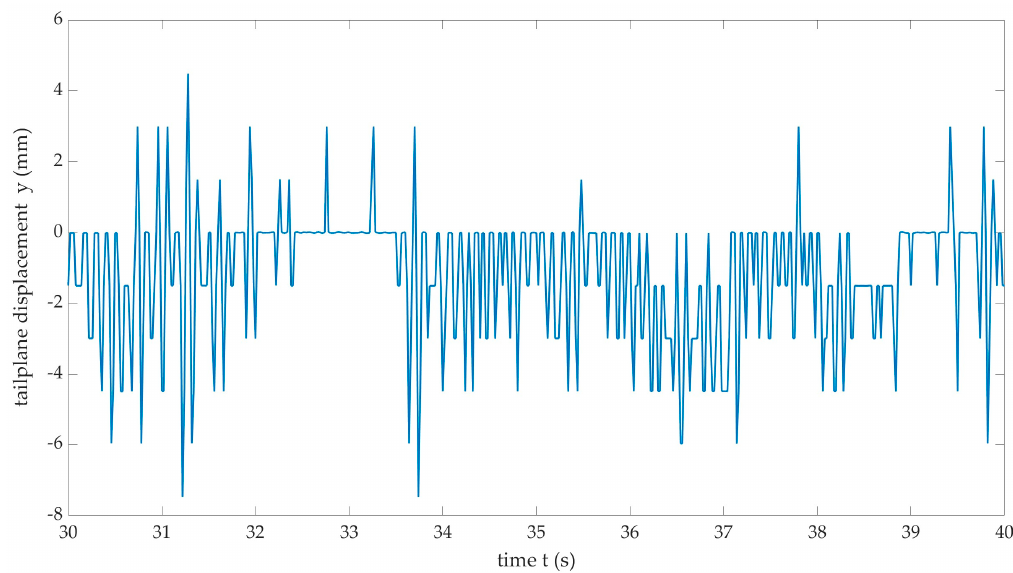
Figure 10. Sample window of time series displacement data from GoPro tailplane image sequence.